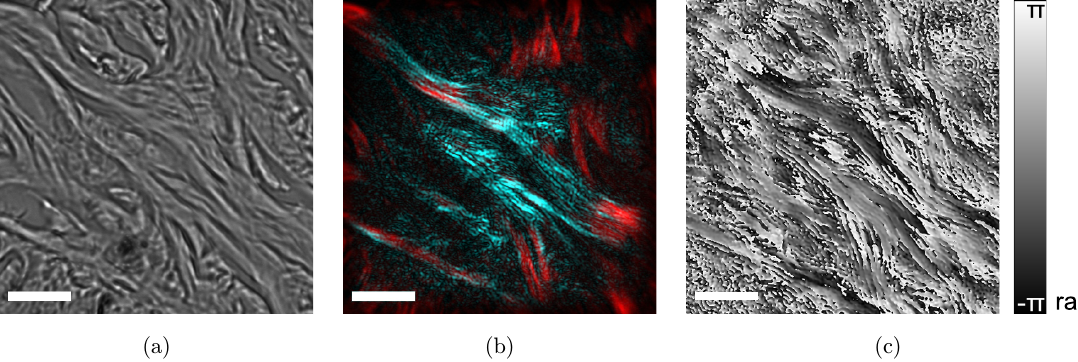
Fig. 3. Mouse tail dermis and epidermis. (a) Bright ¯eld image, (b) Overlay of (red) cross-polarization image showing phase retardation caused by the birefringence of collagen and (blue) SHG amplitude (normalized), (c) phase (wrapped) reconstructed from a single hologram. All images present the same region of the specimen and scale bars are 10 (cid:1) m. Adapted with permission from Ref.